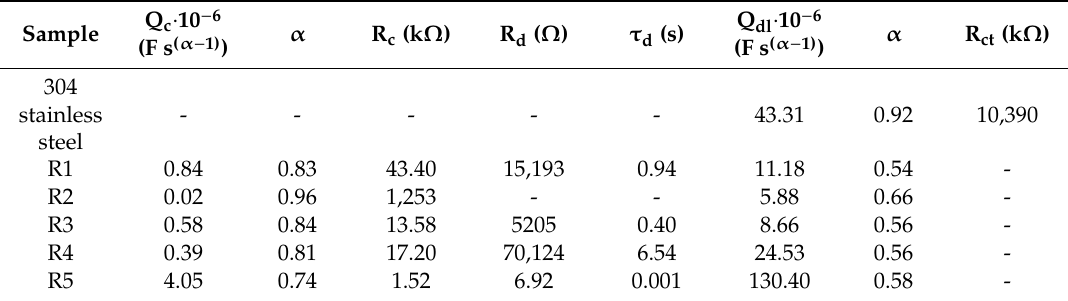
Table 4. Resistor (R), constant phase element parameter (Q) and restricted linear di ff usion (R d , τ d ) components values of di ff erent electric equivalent circuits (EEC) matched to EIS results of bare 304 stainless steel and samples R1–5.